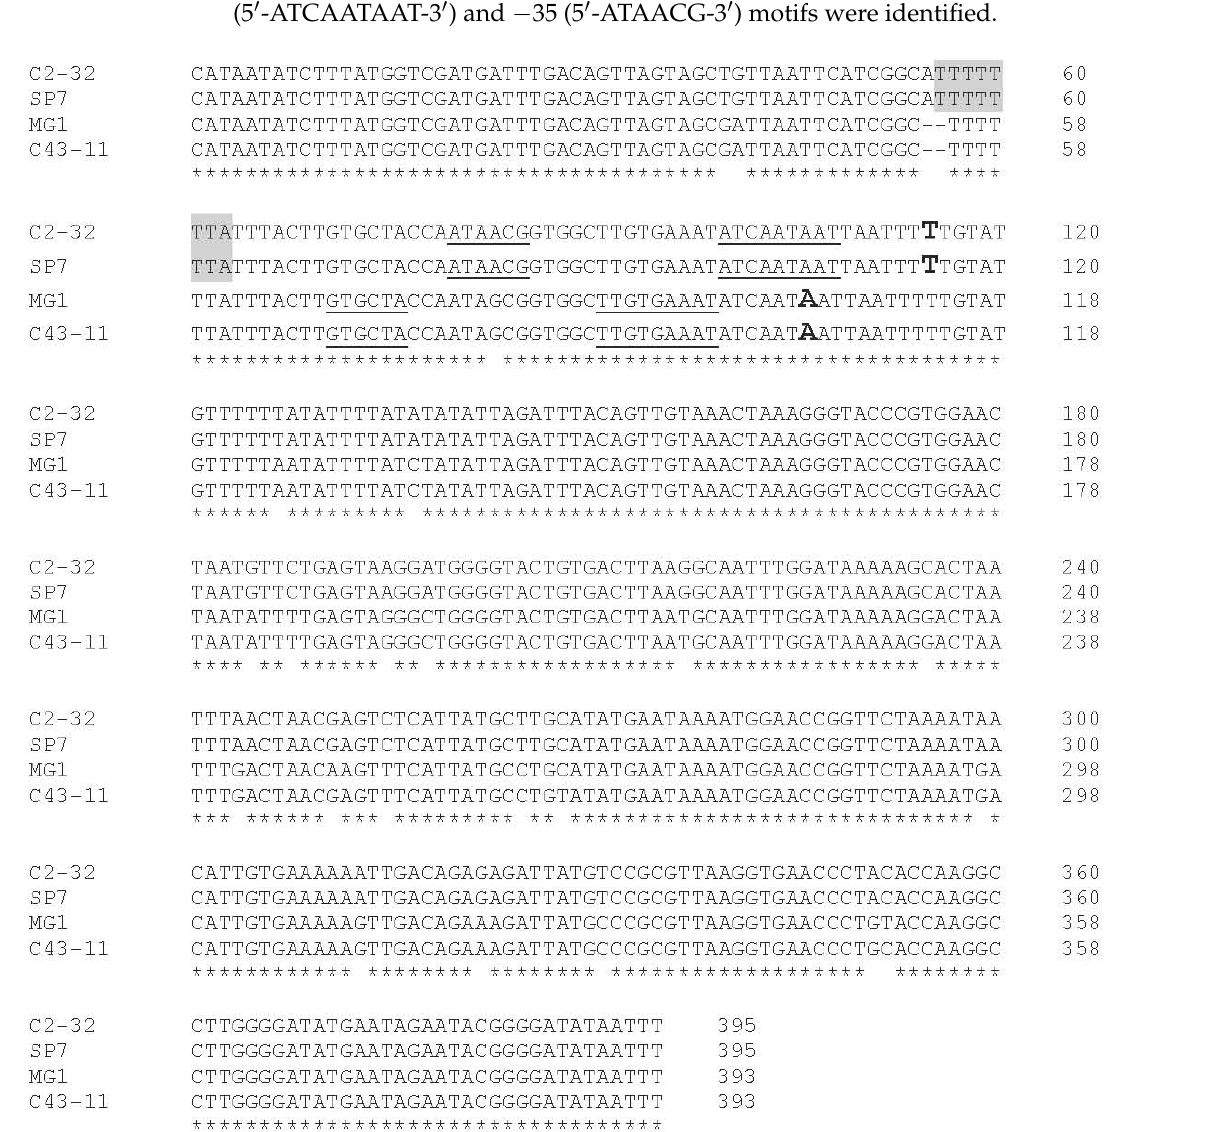
Figure 4. Alignment of the promoter regions of C2-32, C43-11, SP7, and MG1 strains with the in silico predicted − 35 and − 10 motifs ( underlined text ), transcriptional start sites ( bold letters ), and lexA ( light gray ) DNA-binding motif indicated.